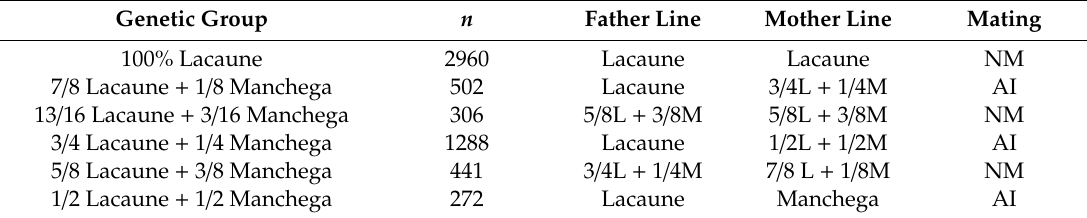
Table 1. Description of the dairy sheep Lacaune (L) with Manchega (M) crossbreeding; parental line was determined with father line (FL) or mother line (ML) crossbreeding, using artificial insemination (AI) or natural mating (NM) rams.